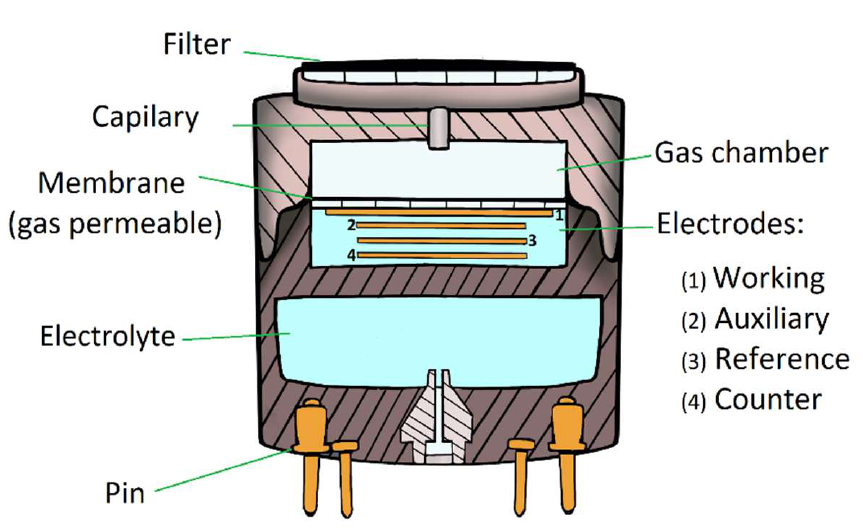
Figure 2. Components of a four-electrode electrochemical sensor for detection of air-polluting gases.